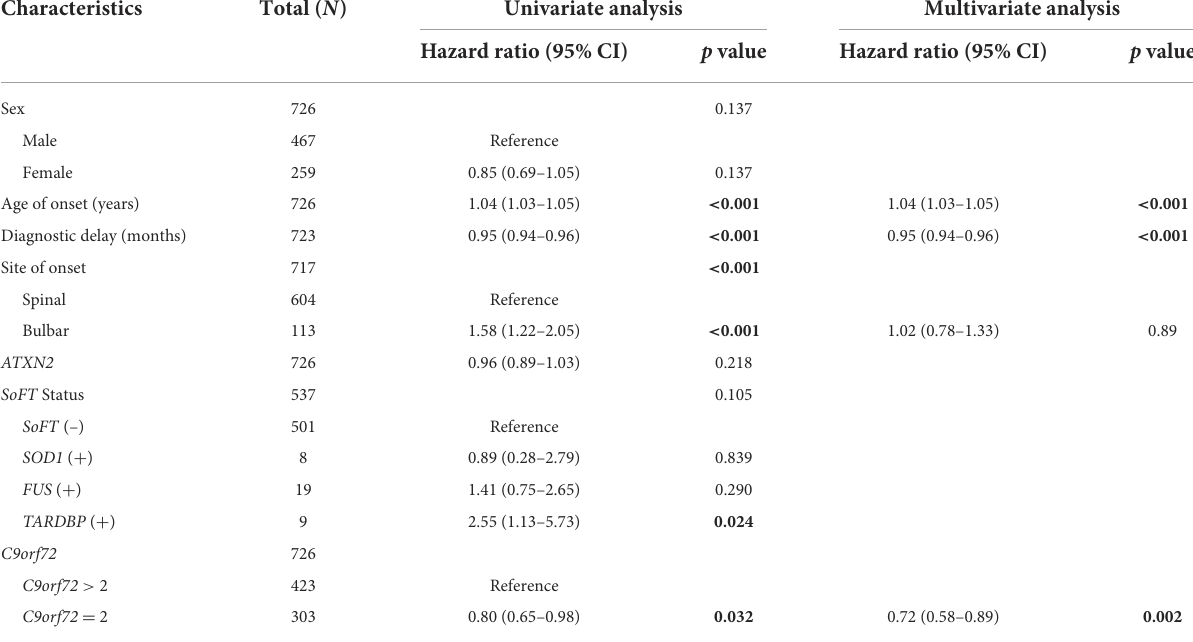
TABLE 2 Cox regression analysis of patients without C9orf72